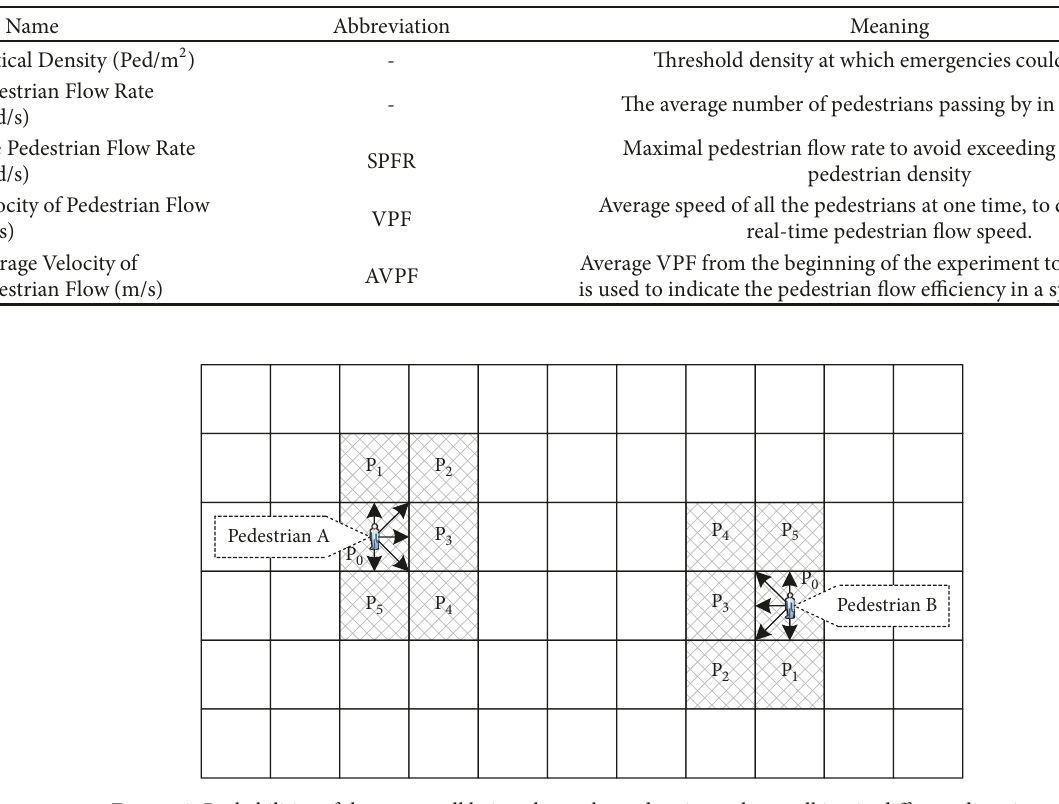
Figure 3: Probabilities of the target cell being chosen by pedestrians when walking in different